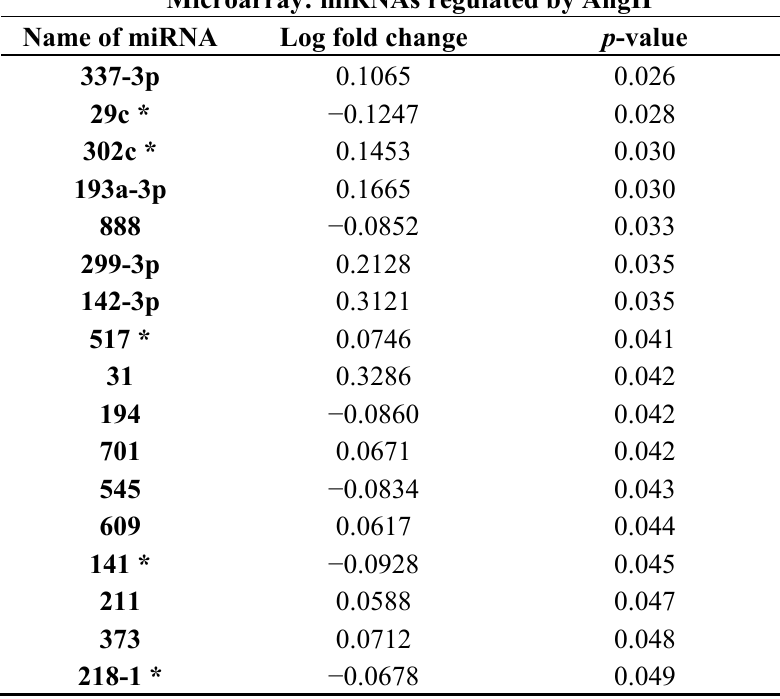
Microarray: miRNAs regulated by